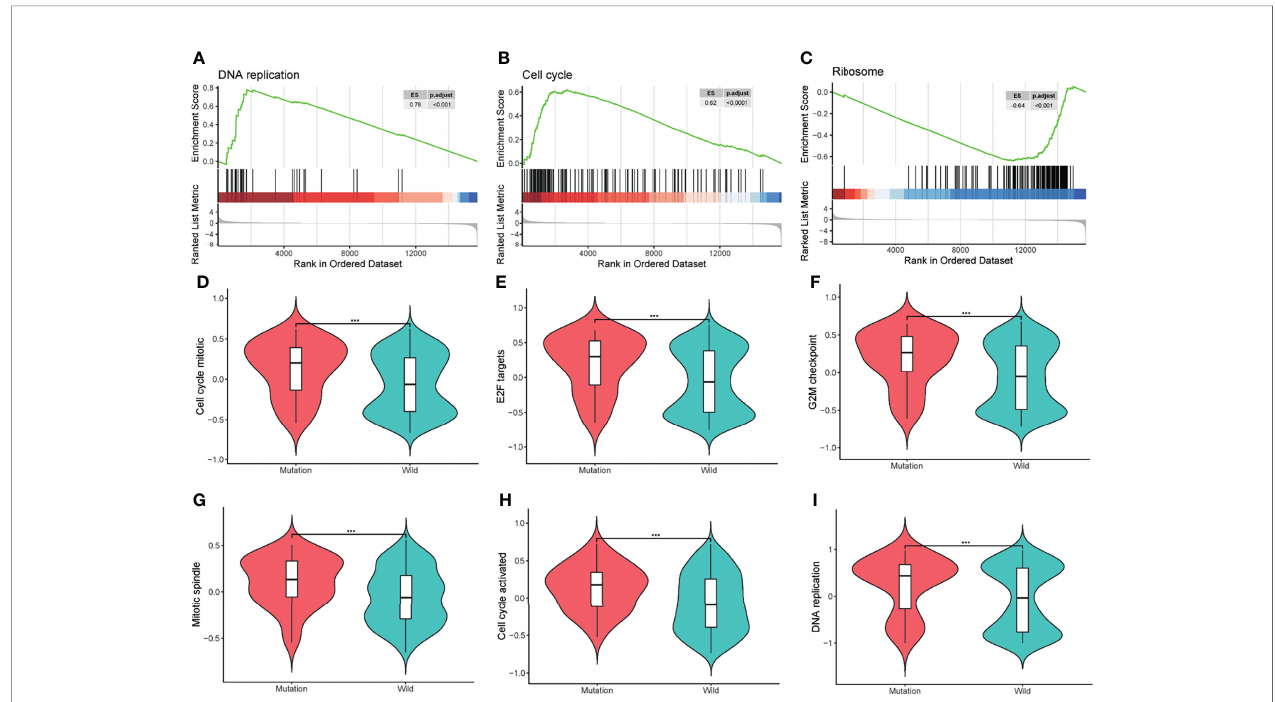
FIGURE 4 | Gene Set Enrichment Analysis (GSEA) and Gene Set Variation Analysis (GSVA). (A – C) GSEA of all the protein-coding genes between the two groups. ES, enrichment score; p.adjust, adjusted p-value. (D – I) GSVA of the cell cycle-related events between the mutation and wild groups. ***P < 0.001